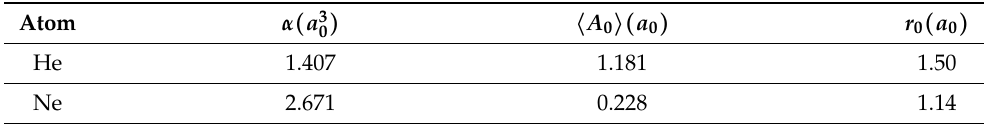
Table 6. Parameters used in the rigid sphere model: the dipole polarizability ( α ), the mean value of the scattering length determined in the present MERT analysis ( (cid:104) A 0 (cid:105) ), and the rigid sphere radius ( r 0 ) determined from Equation